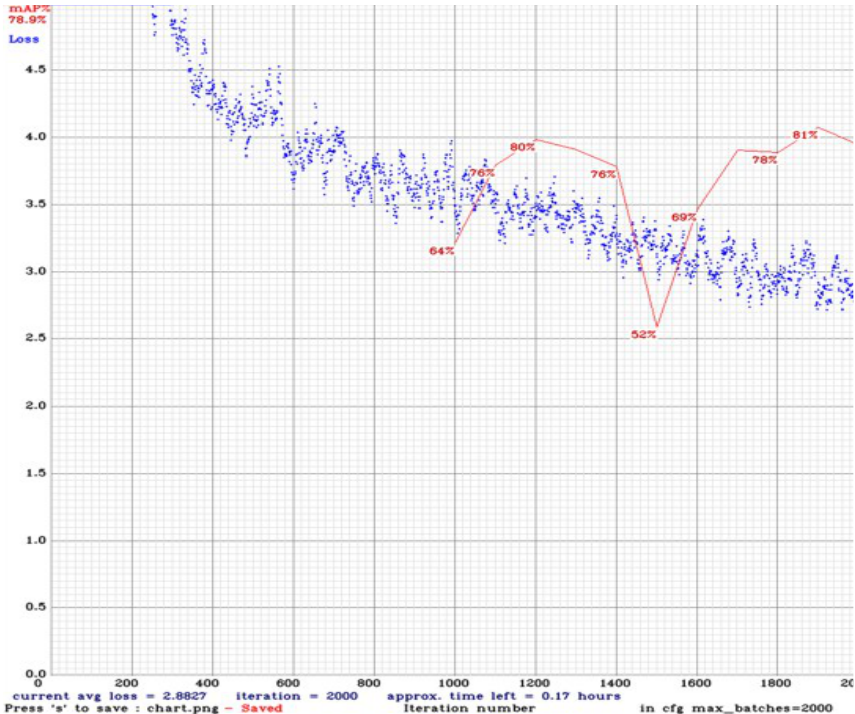
Figure 12. mAP and training Loss graph of first 2000 epochs.